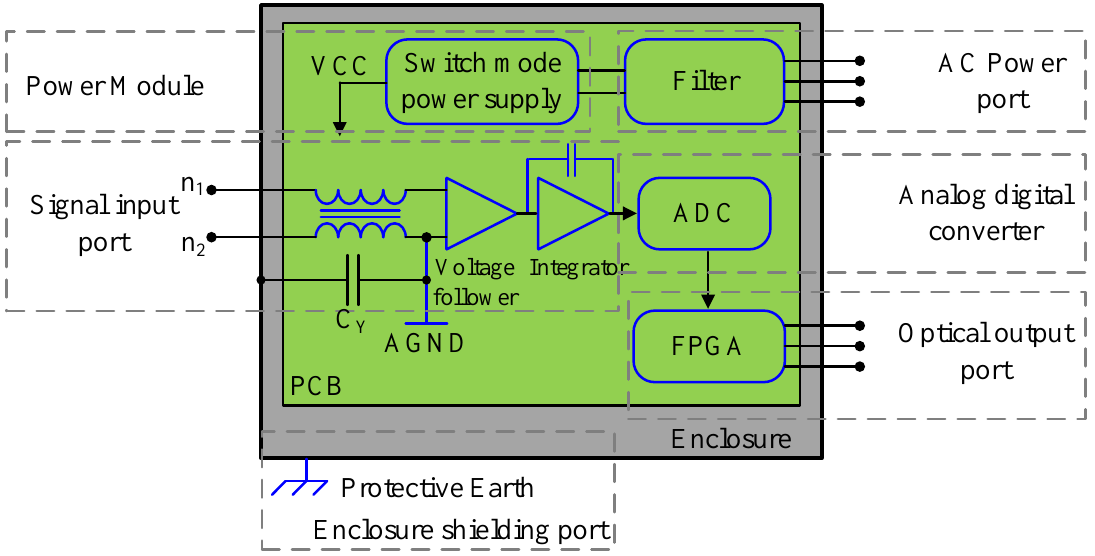
Figure 3. The function block diagram and port definition of the ECT acquisition card.